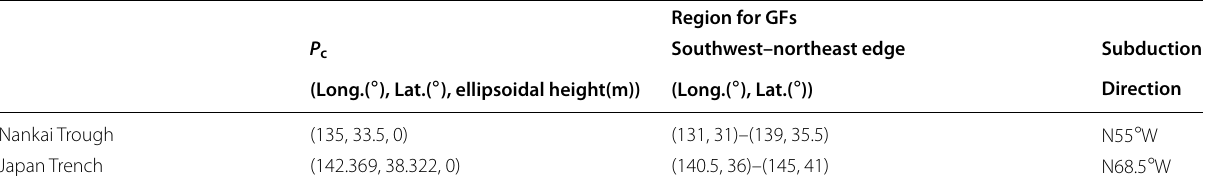
Table 1 Location of P c , the area for calculating GFs and the subduction direction in the Nankai Trough and the Japan Trench subduction zone, respectively